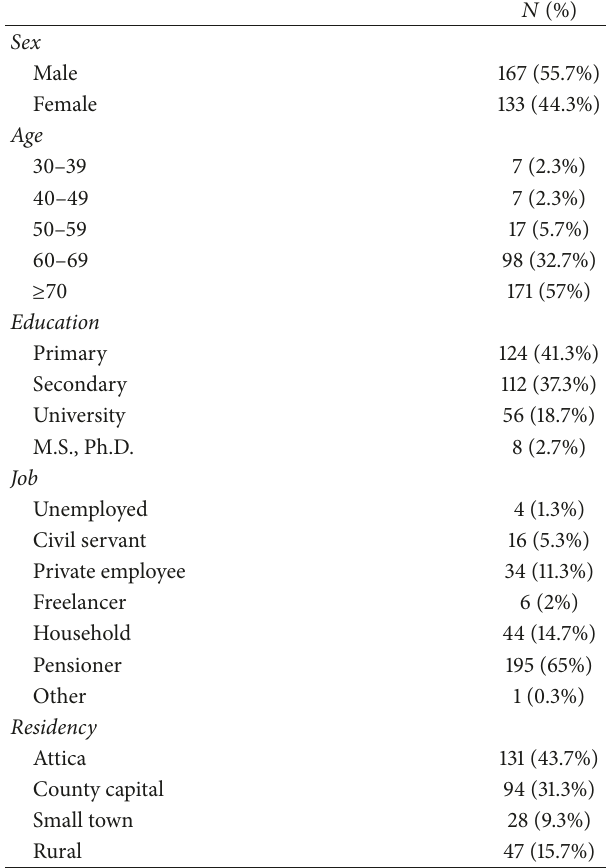
Table 1: Patients characteristics ( 𝑁 = 300